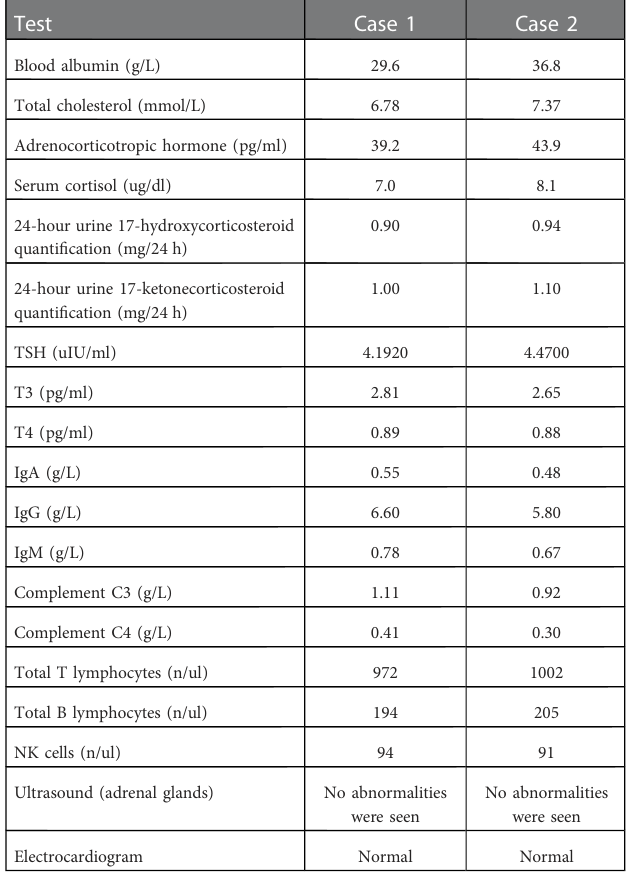
TABLE 2 Extra-renal symptom assessment indicators for case 1 and case